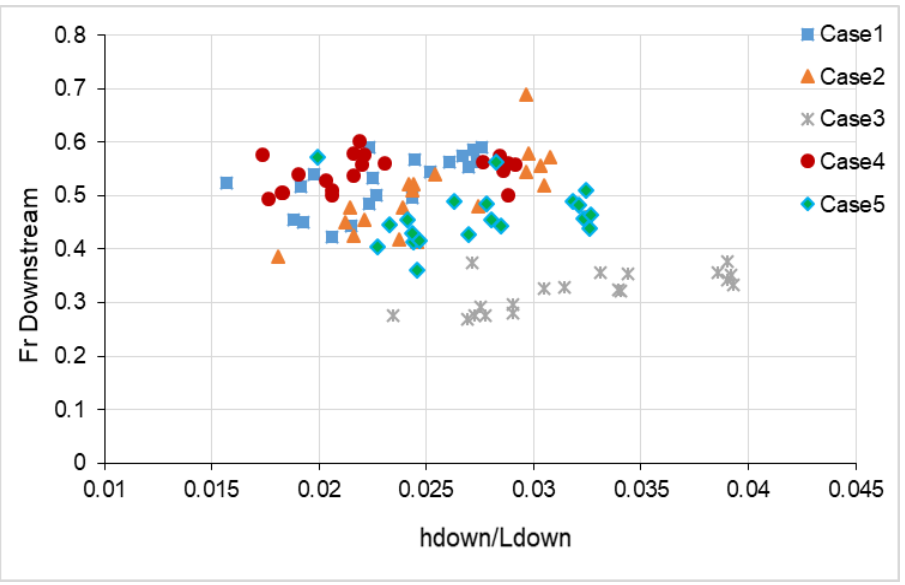
Figure 6. Relation between downstream Froude number and